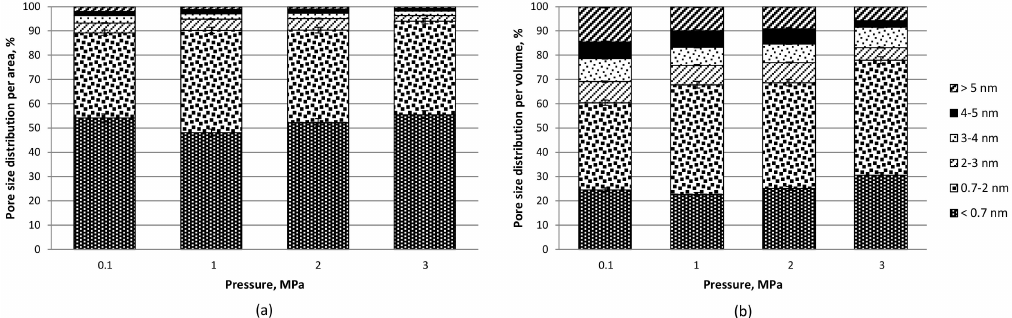
Figure 4. Distribution of: ( a ) pore area and ( b ) volume based on nitrogen isotherms at − 196 ◦ C and DFT method for olive pomace-derived carbon materials produced at 800 ◦ C, under 0.1–3 MPa and with carbon dioxide